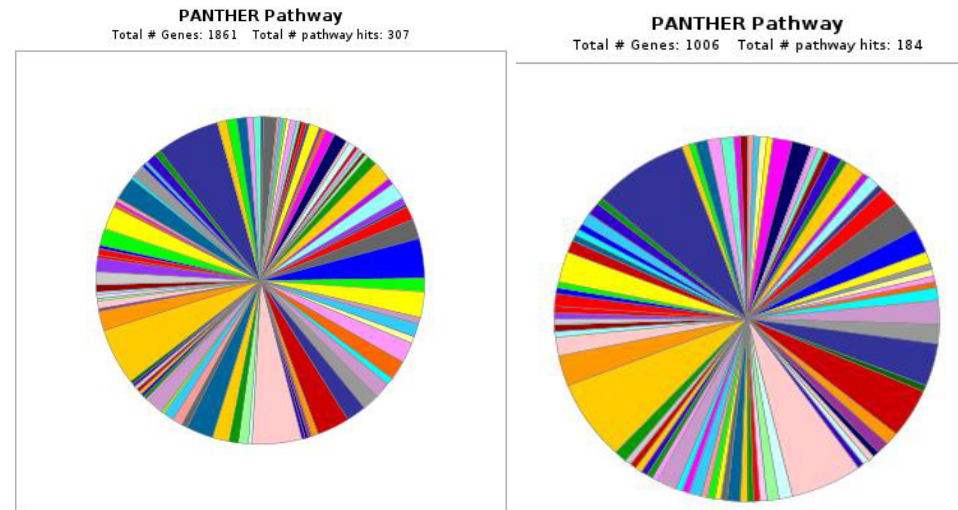
Figure 6. Gene Ontology classification of pathways using PANTHER in HBGH35 and Pusa Naveen ( ♀ ).